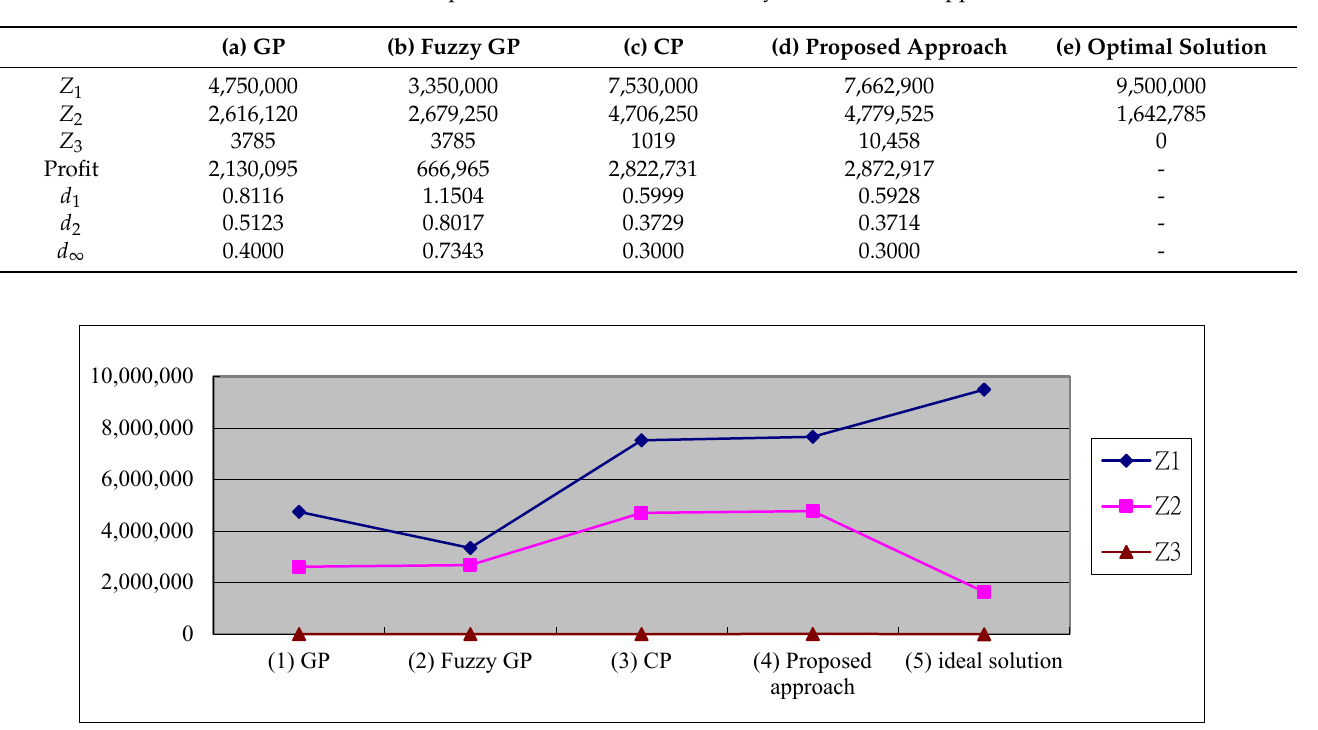
Table 9. Comparison of Solutions Obtained by Four Different Approaches.